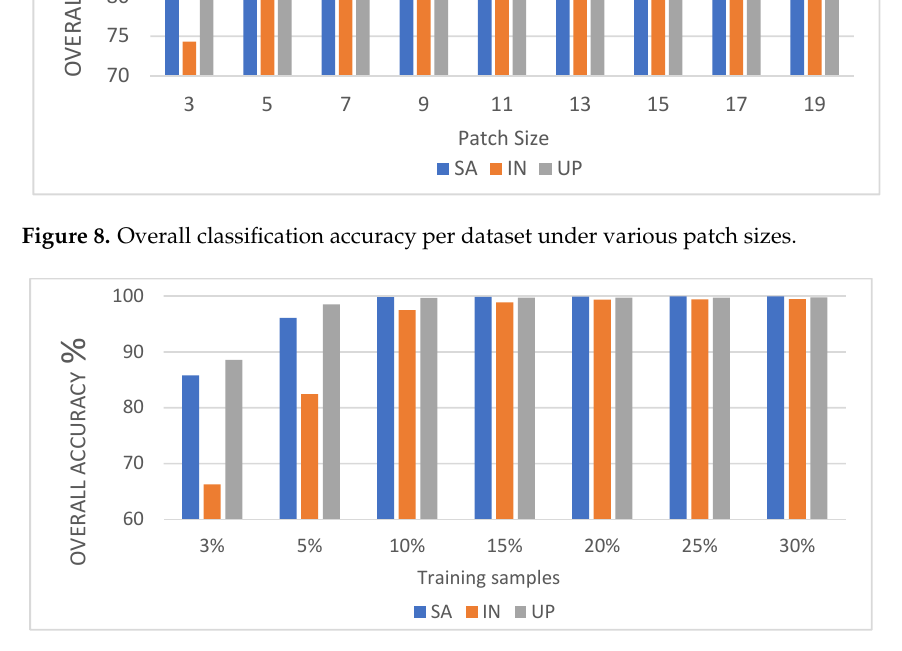
Figure 9. Overall classification accuracy per dataset under various proportions of training samples.